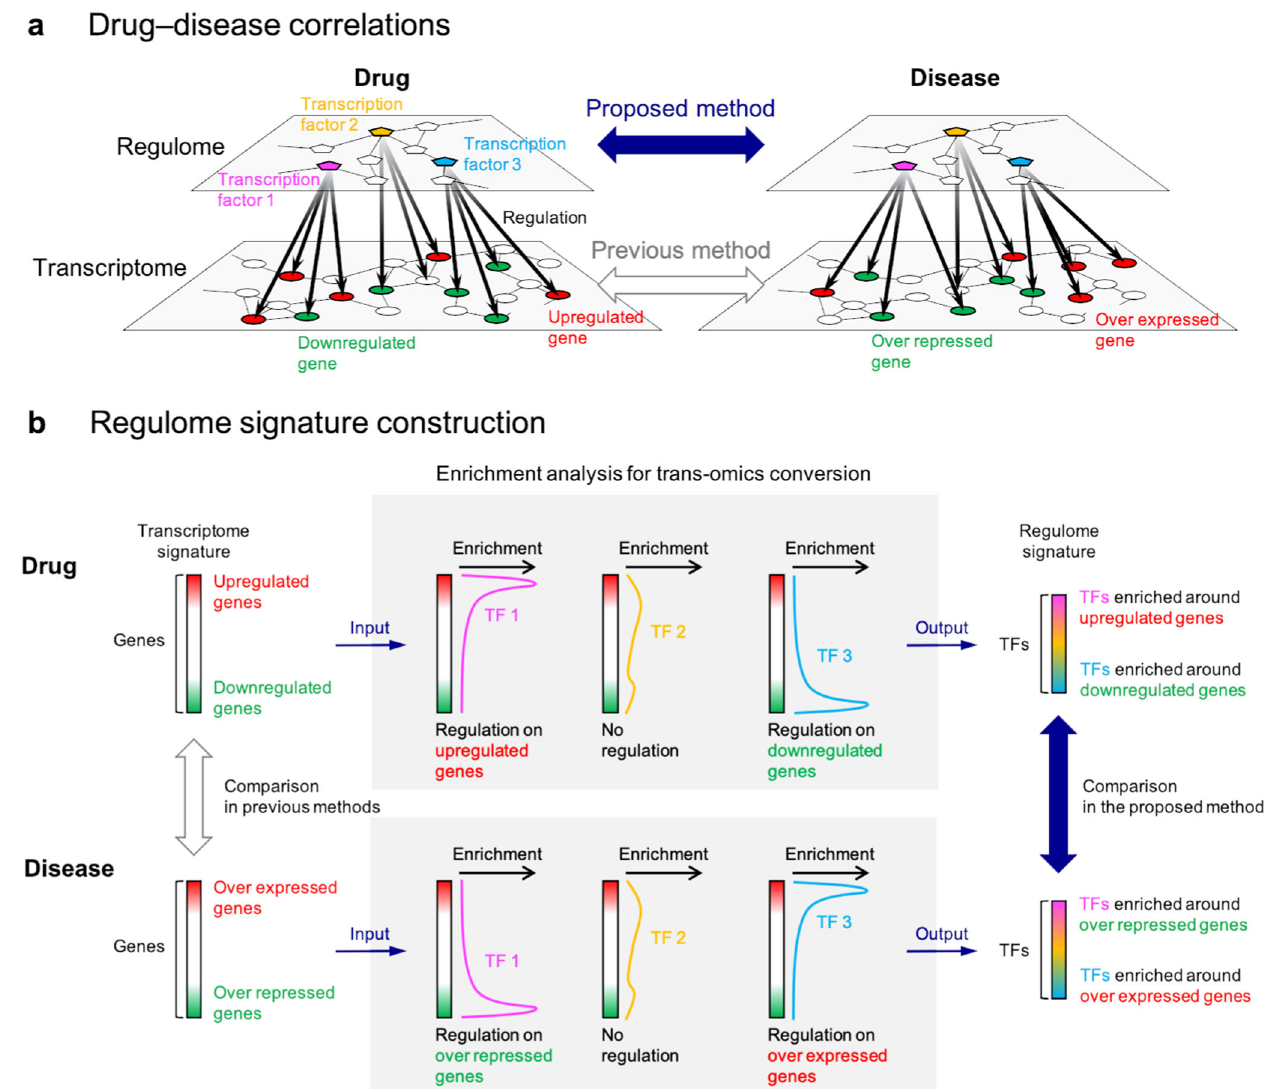
Fig. 1 Overview of the proposed method. a Evaluation of drug − disease correlations at the different omics level. Circles in the transcriptome layer denote genes and pentagons in the regulome layer denotes transcription factors. b Conversion of transcriptome signatures into regulome signatures. Drug-induced and disease-speci fi c transcriptome signatures are converted into regulome signatures. Up- and downregulated genes in drug-induced transcriptome signatures and over expressed and repressed genes in disease-speci fi c transcriptome signatures are manually extracted (left). Enrichment of transcription factors on the regulated genes are statistically evaluated on the ChIP-Atlas platform (center). The resulting FDR-corrected p -values are used for constructing regulome signatures